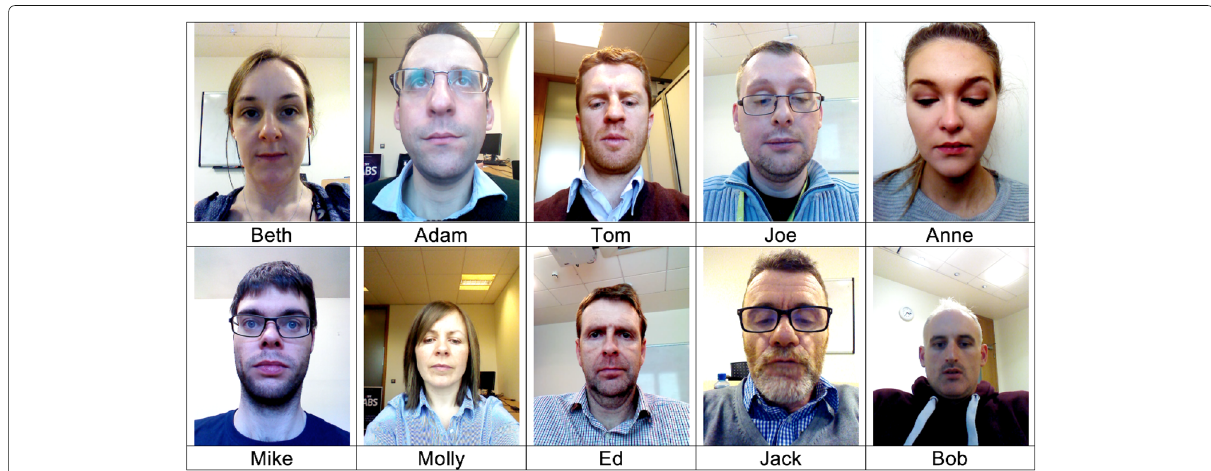
Fig. 4 Sample of the qFace dataset: 10 users consisting of 7 males and 3 females, with each user’s reference name. Real-world data collected on handheld mobile